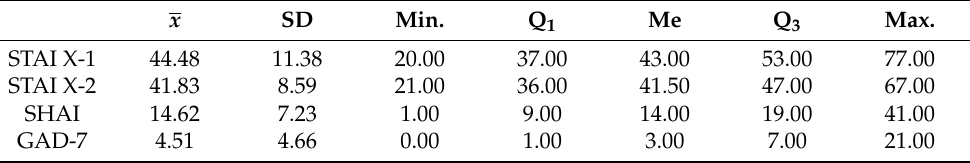
Table 2. Descriptive statistics for the scales applied in the